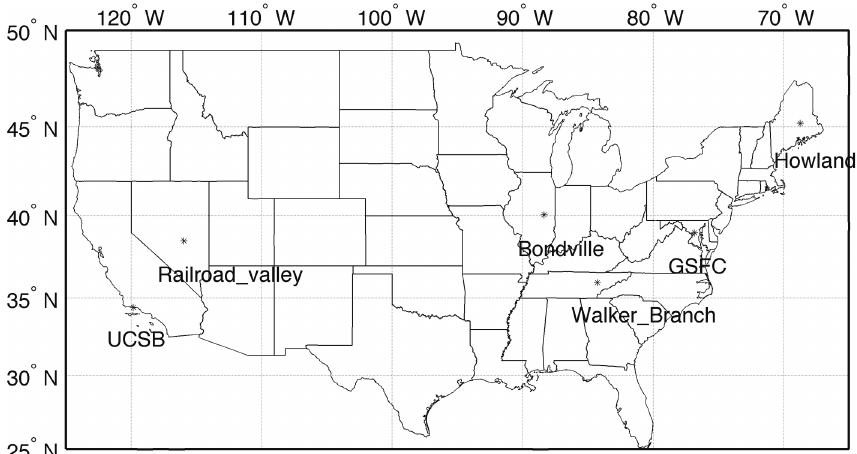
Fig. 1. Locations of the AERONET sites used for